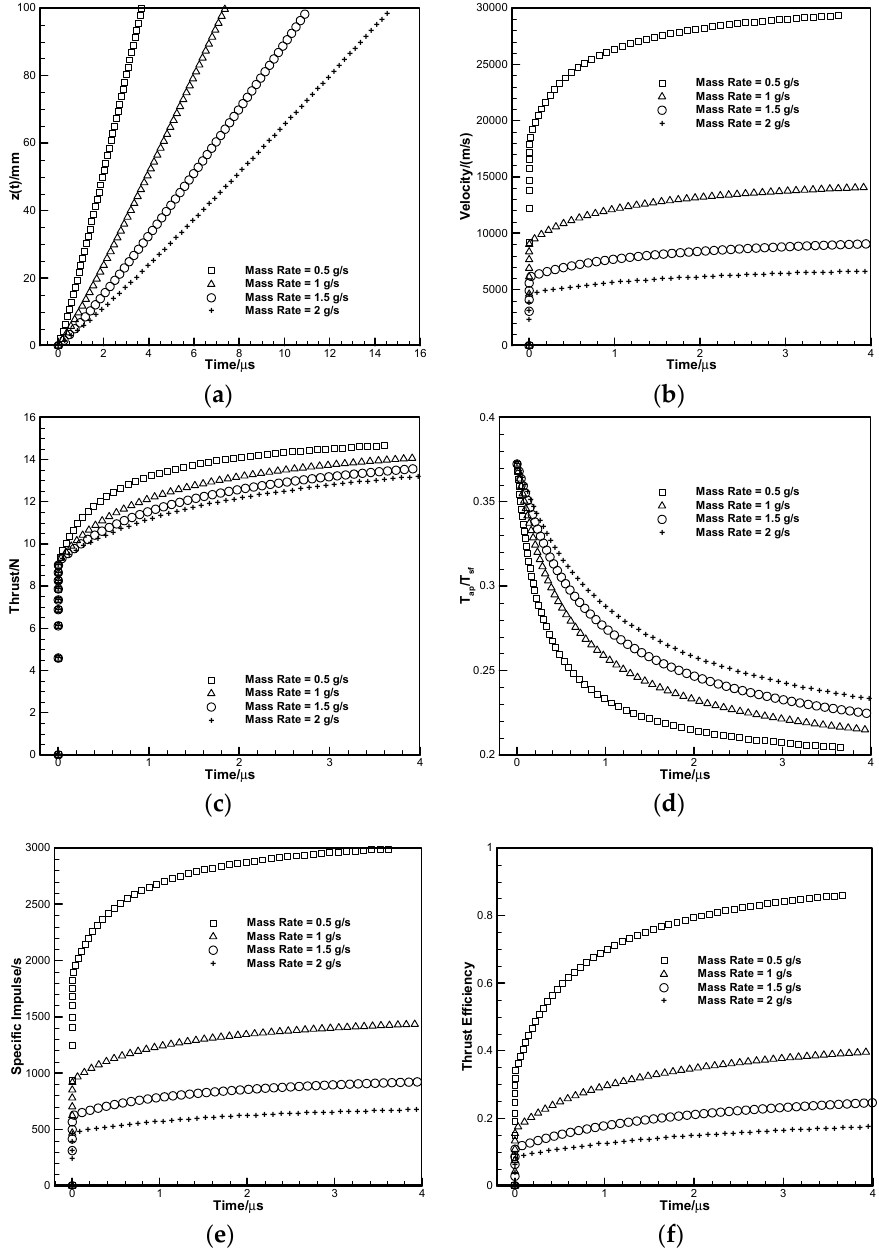
Figure 10. Effects of mass flow rate on thrust performances: ( a ) Axial movement of current sheet; ( b ) Velocity of current sheet; ( c ) Thrust; ( d ) Ratio of applied-field thrust to self-field thrust; ( e ) Specific impulse; ( f ) Thrust efficiency.